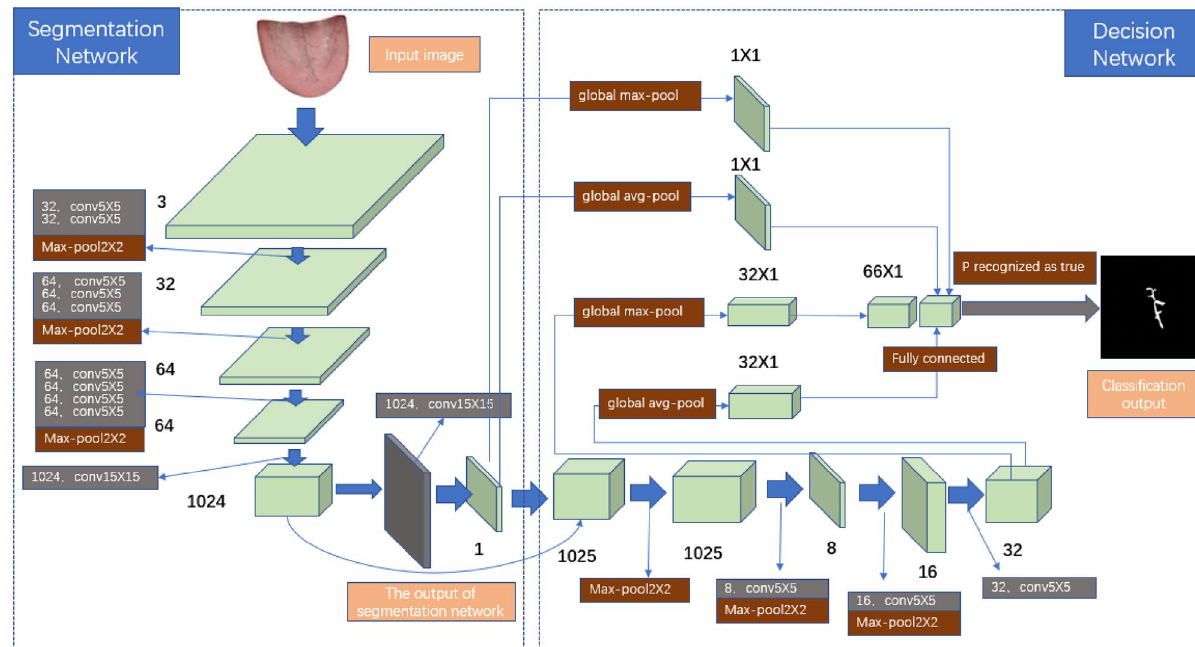
Figure 5. The network architecture of